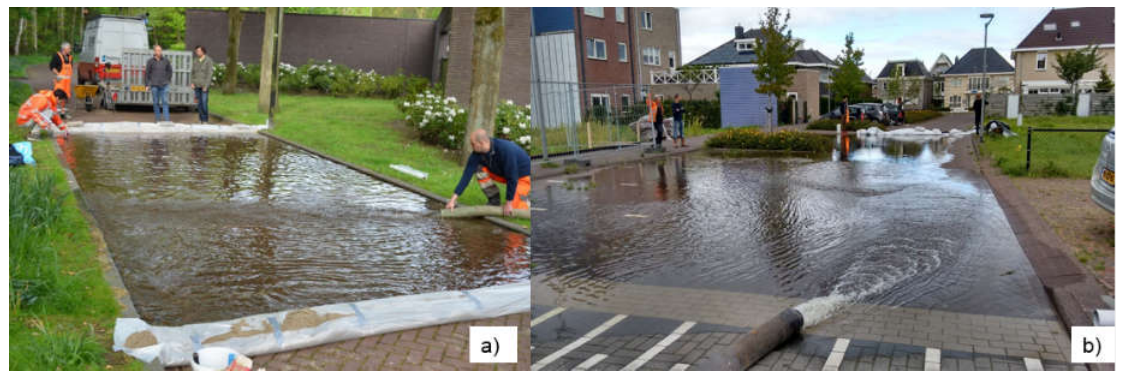
Figure 5. Temporary dams and water supply for full-scale infiltration testing (FSIT).